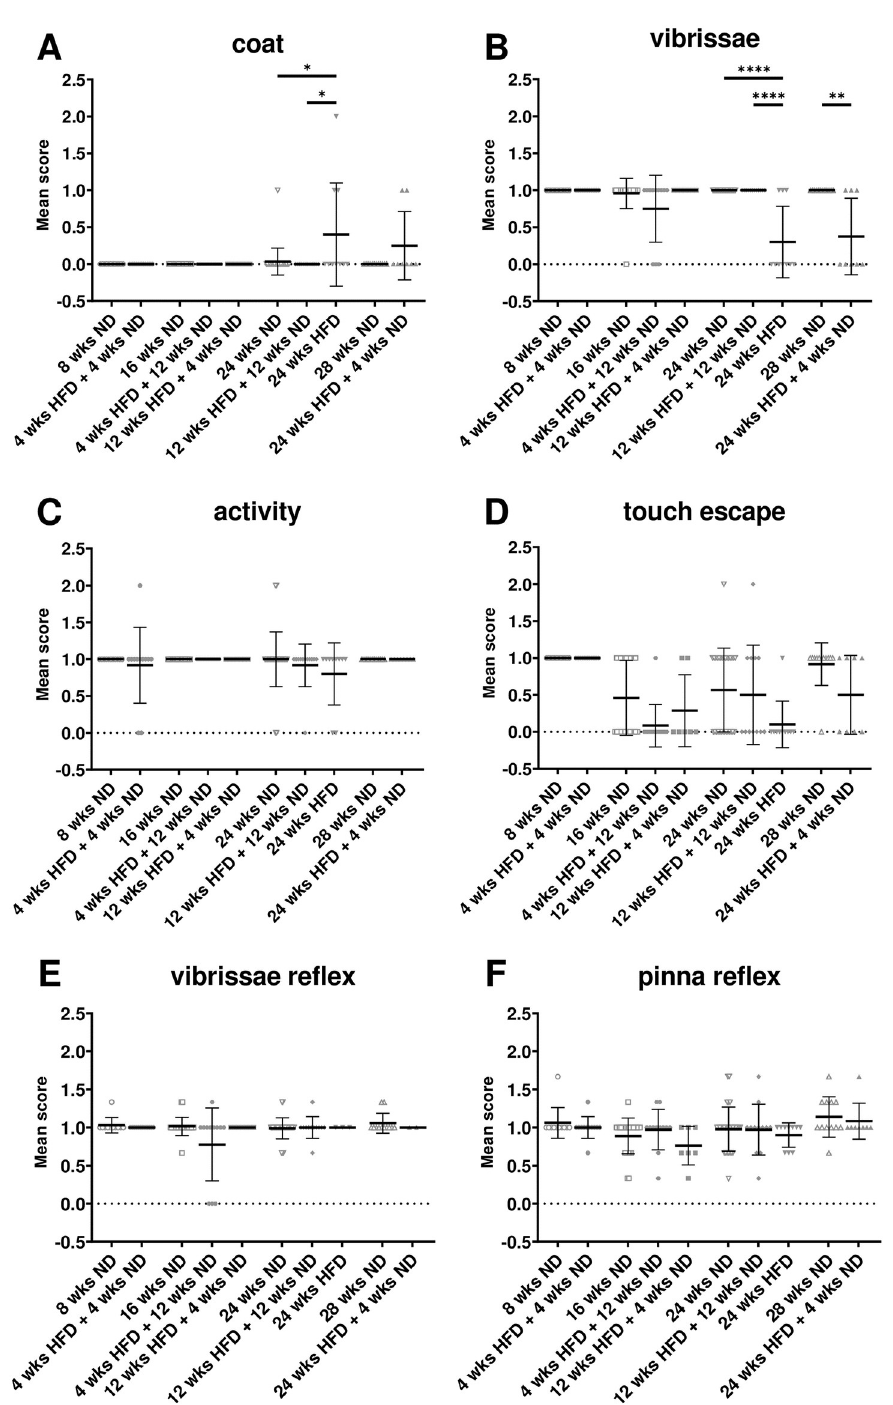
Fig 2. HFD leads to general health issues. (A-D) SHIRPA analysis was used to estimate general health of mice after ND or HFD. (A) Long-term HFD led to problems with the coat and (B) the loss of vibrissae, while there was more variance, but no significant difference after HFD in (C) general activity and (D) touch escape. Normal sensory reflexes as the (E) vibrissae and the (F) pinna reflex were observed in all groups irrespective of diet or age. Data are presented as mean values and error bars indicate SD; 8 wks ND n = 11, 4 wks HFD + 4 wks ND n = 12, 16 wks ND n = 24, 4 wks HFD + 12 wks ND n = 12, 12 wks HFD + 4 wks ND n = 7, 24 wks ND n = 30, 12 wks HFD + 12 wks ND n = 12, 24 wks HFD n = 10, 28 wks ND n = 12, 24 wks HFD + 4 wks ND n = 8; Kruskal-Wallis test, Mann-Whitney test; ���� p < 0.0001; �� p < 0.01; � p < 0.05.